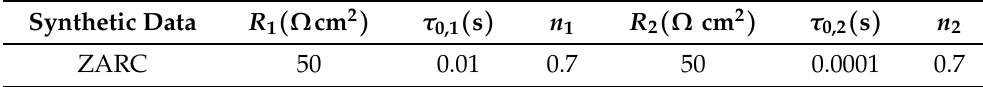
Table 6. Parameters used to compute single and double ZARC data.